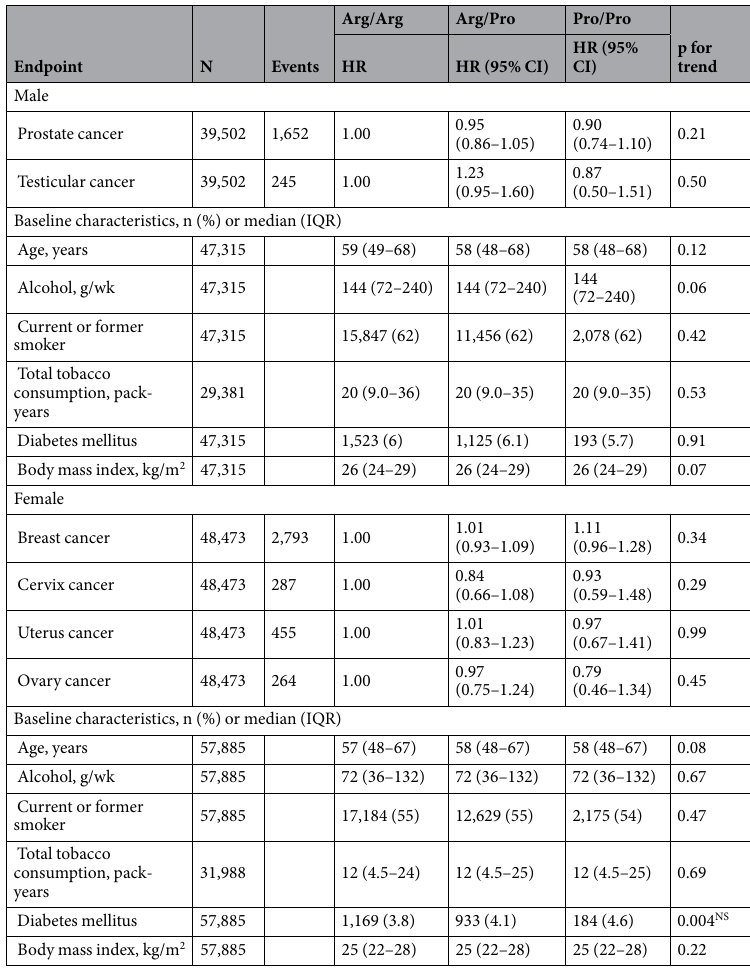
Table 2. Incidence of sex-specific cancers and distribution of baseline characteristics according to sex and TP53 Arg72Pro genotype. Data on baseline characteristics are expressed as number and percentage for categorical values and median and interquartile range (IQR) for continuous values. Hazard ratios for cancer endpoints were adjusted for sex and age. Follow-up started at the day of birth or for individuals born before 1943 at the start of the national Danish Cancer Registry and ended at cancer diagnosis, death, emigration, or December 31, 2012 whichever came first. Total tobacco consumption was calculated for current and former smokers only. P-values were calculated using Cuzick’s test for trend or a Cox regression using Arg72Pro genotype as a continuous variable. The nominal values are shown without prior adjustment for multiple comparisons. NS Insignificant after Bonferroni correction for 18 multiple tests. Required p-value = 0.003 ( = 0.05/18). HR, Hazard ratio; CI, Confidence